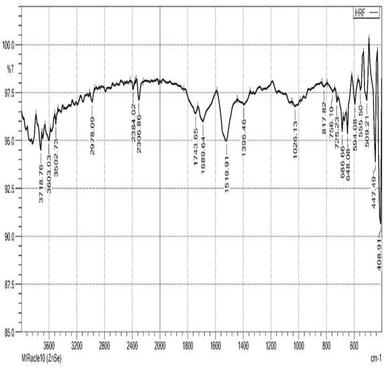
FTIR analysis of HRF.